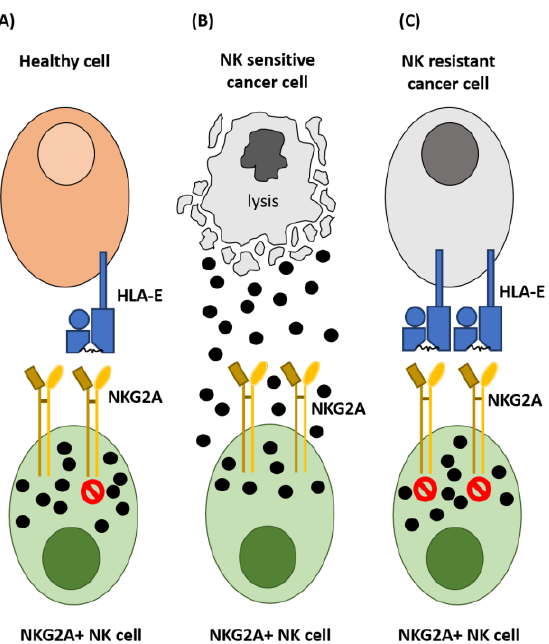
Figure 1. HLA-E:NKG2A regulation of NK cell cytotoxicity. ( A ) HLA-E presents HLA class I signal peptides to the inhibitory NK cell receptor NKG2A. HLA-E expression on nucleated, healthy cells negates NKG2A+ NK cell cytotoxicity toward healthy tissues. ( B ) Downregulation of HLA-E